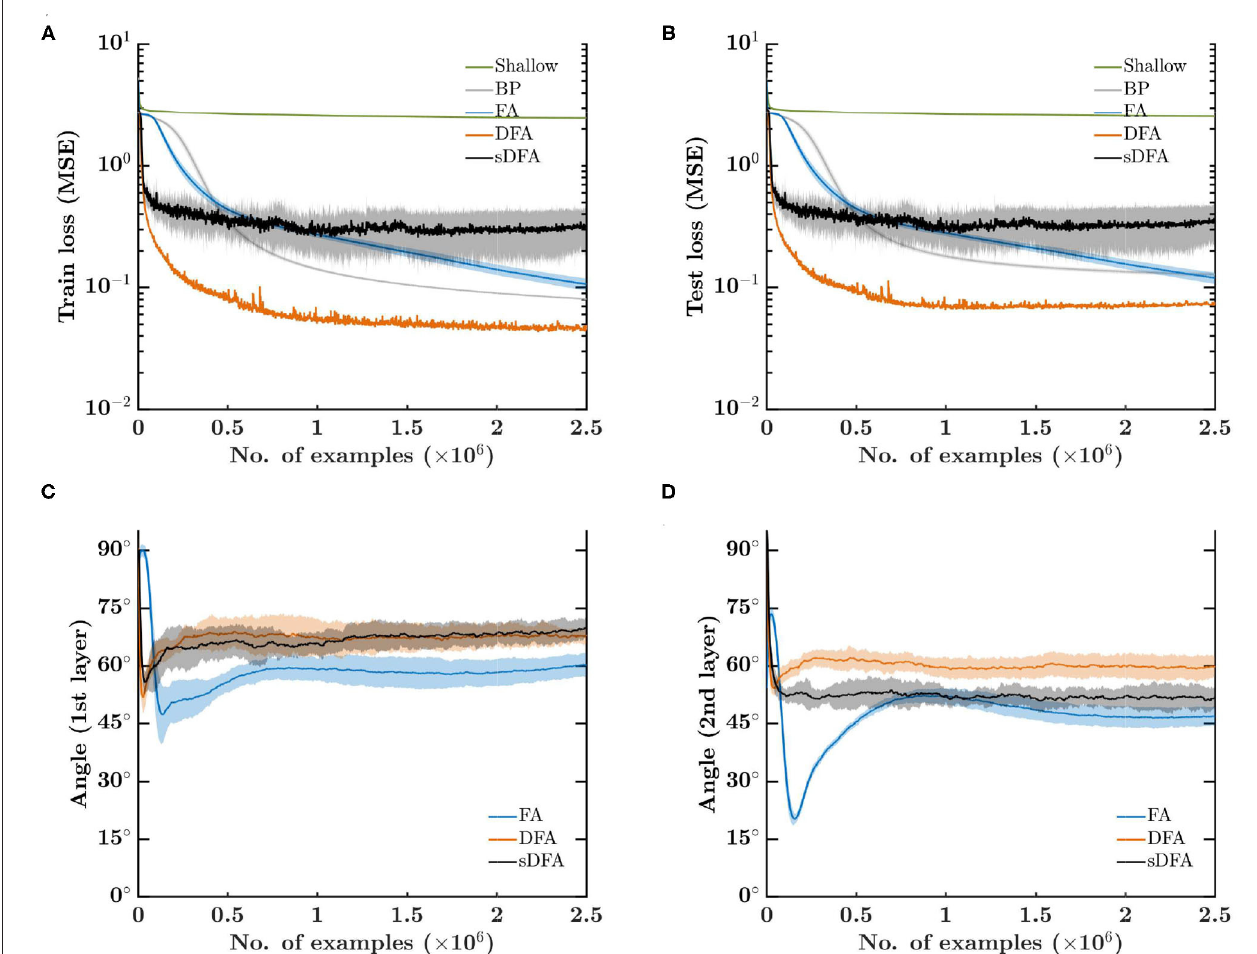
FIGURE 2 | Error-sign-based direct feedback alignment (sDFA) provides useful modulatory signals in regression tasks. A 256-100-100-10 network with tanh hidden and output units is trained to learn cosine functions with five training algorithms: shallow learning, BP, FA, DFA and sDFA. With this simple setup, BP and FA suffer from the vanishing gradients problem, which would be alleviated by using ReLU-based networks with batch normalization. The scope of the figure is to highlight that sDFA provides useful modulatory signals for regression tasks, without any additional technique. As for other feedback-alignment-based algorithms, sDFA updates are within 90 ◦ of the backpropagation updates. The train and test losses and the alignment angles are monitored every 1k samples, error bars are one standard deviation over 10 runs. Angles have been smoothed by an exponentially-weighted moving average filter with a momentum coefficient of 0.95. (A) Mean squared error loss on the 5k-example training set. (B) Mean squared error loss on the 1k-example test set. (C) Angle between the modulatory signals δ z k prescribed by BP and by feedback-alignment-based algorithms in the first hidden layer. (D) Angle between the modulatory signals δ z k prescribed by BP and by feedback-alignment-based algorithms in the second hidden